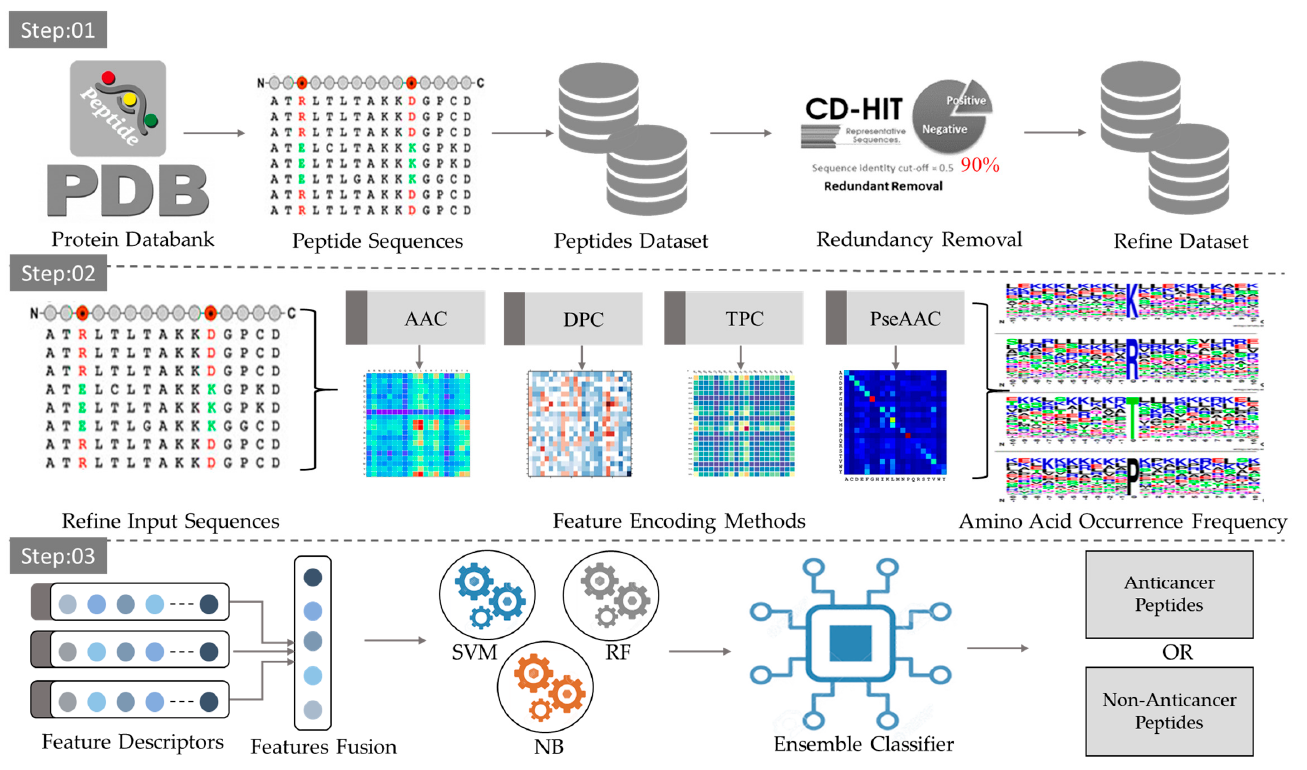
Figure 2. The proposed framework for the classification of ACPs and